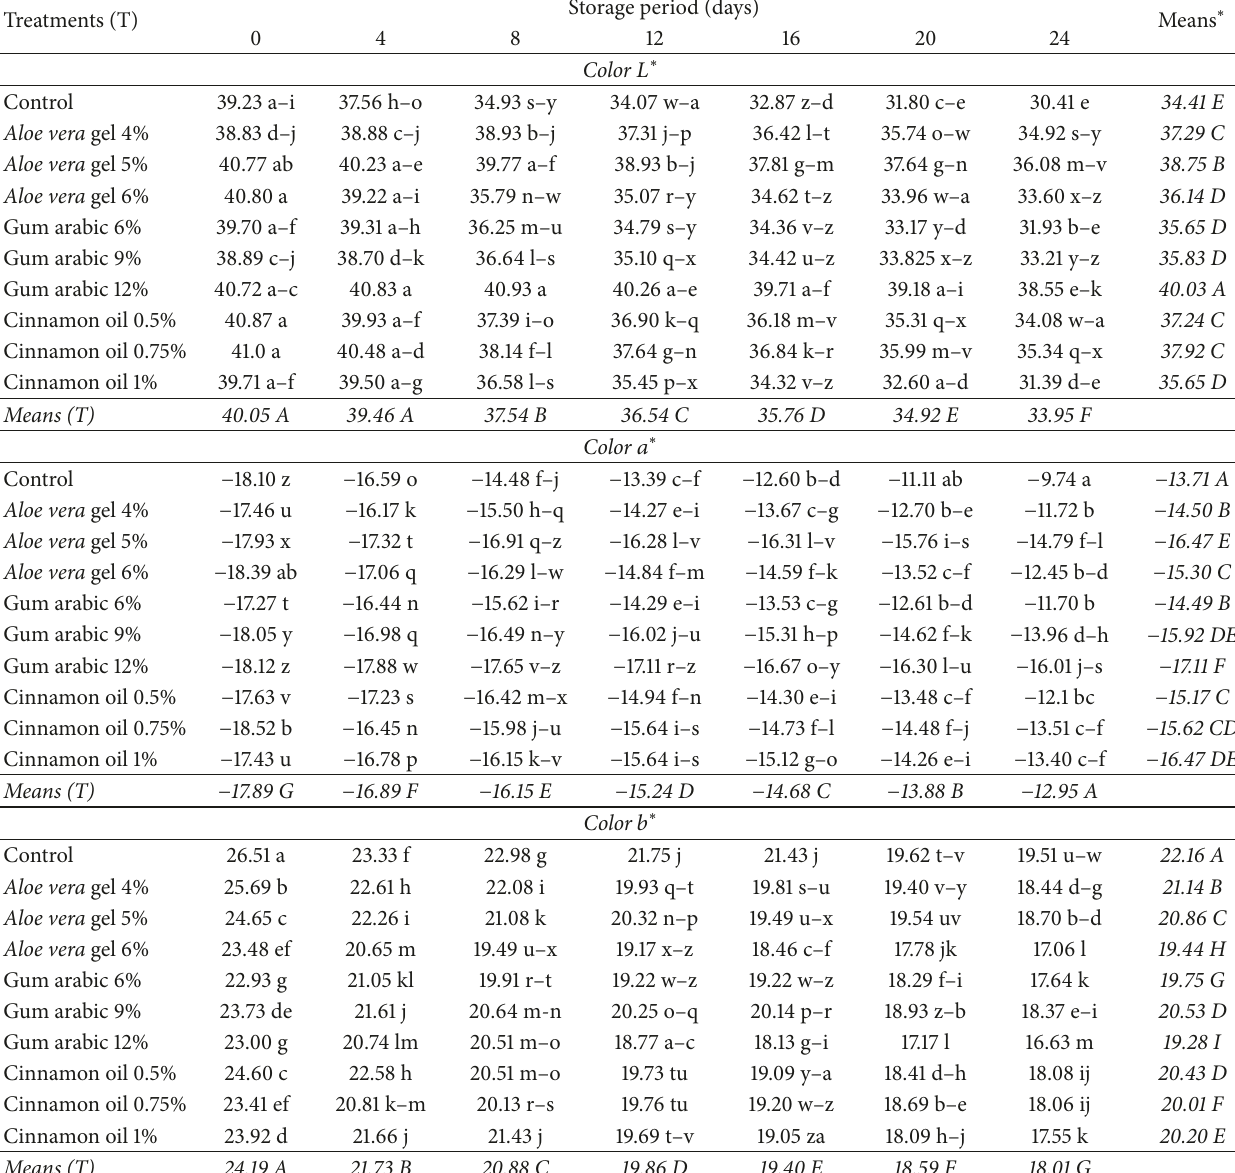
Table 1: Effect of Aloe vera gel, gum arabic, and cinnamon oil on color 𝐿 ∗ , color 𝑎 ∗ , and color 𝑏 ∗ of bell pepper during cold